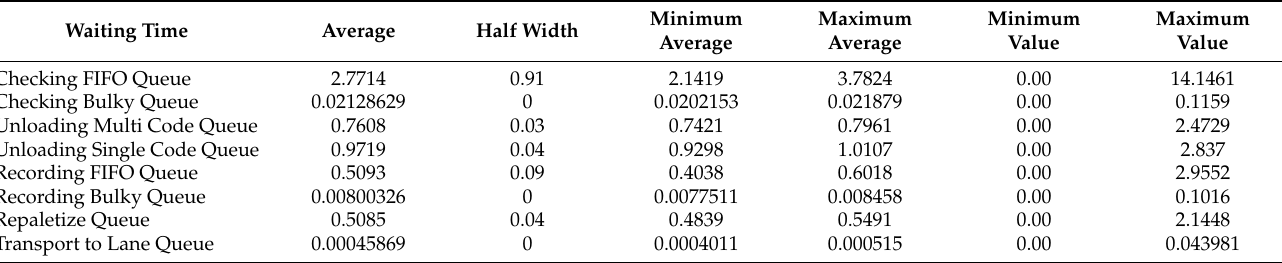
Table 6. Occupancy rate per task—Waiting Time.